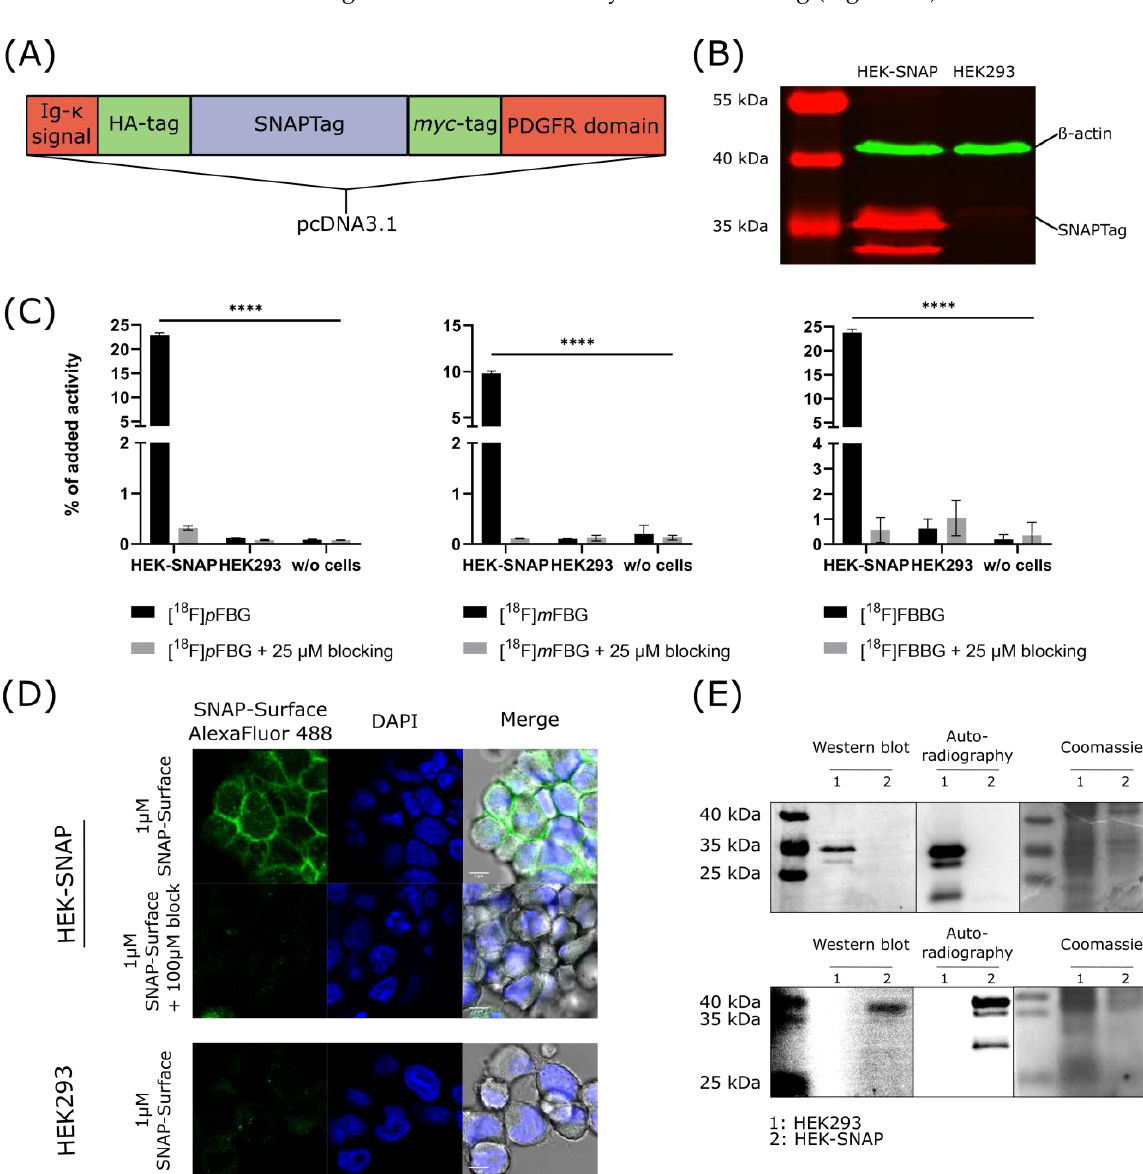
Figure 2. In vitro characterization of the HEK-SNAP cells. ( A ) Schematic depiction of the construct expressed by the HEK-SNAP cells. ( B ) Western blot of HEK-SNAP cell lysate. The HEK-SNAP cells show a band at the expected size of the SNAPTag (anti- myc antibody, 33 kDa, red) while HEK293 control cells show no band at this size. β-Actin was used as loading control. ( C ) Cell uptake experiments with [ 18 F] p FBG, [ 18 F] m FBG and [ 18 F]FBBG. All radiotracers revealed high accumulation in HEK-SNAP cells whereas the control cells only show background uptake. ( D ) Fluorescence microscopy images of HEK-SNAP cells and HEK293 control cells that confirm the expression of the SNAPTag on the cell surface. ( E ) SDS-PAGE autoradiographs of cell lysates incubated with either [ 18 F] p FBG (upper image) or [ 18 F]FBBG (lower image) showing the SNAPTag at the expected size with validation by Western blot and Coomassie staining as loading control.